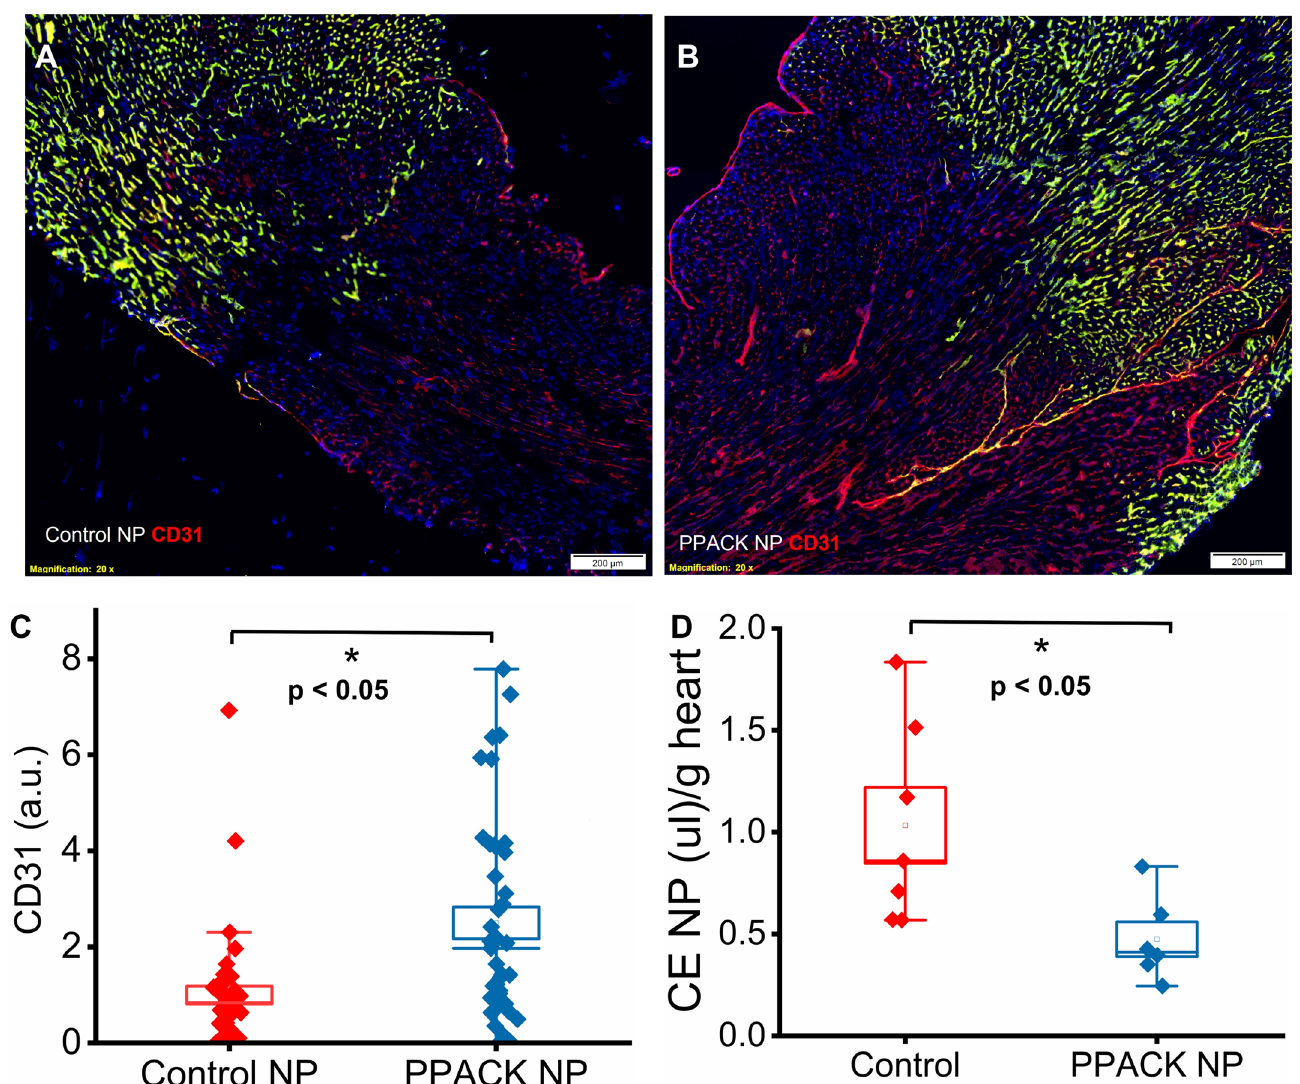
Figure 4. PPACK perfluorocarbon nanoparticles protected micro-vasculature. ( A ) Immunofluorescent image of CD31 staining (red) in control NP-treated mouse. ( B ) Immunofluorescent image of CD31 staining (red) of the PPACK NP treated mouse. The size of the scale bar was 200 µm, and the magnification was 20×. Green fluorescence signal indicates blood vessels in the normal region of the heat. DAPI was used for nuclei staining (blue). Yellowish indicated blood vessels in the normal region registered by both CD31 staining (red) and Lycopersicon Esculentum lectin DyLight 488 (green). ( C ) Quantification of CD31 in border zones of mice treated with either control NP or PPACK NP ( n = 3 mice per group; n = 41 PPACK NP and n = 42 control NP regions of interest. Mean ± SEM; nonparametric analysis on n = 3). ( D ) Quantification of CE nanoparticles trapped in rat hearts after ischemia reperfusion injury. ( n = 6 PPACK NP and n = 7 control NP treated whole hearts. Mean ± SEM; *: p < 0.05).